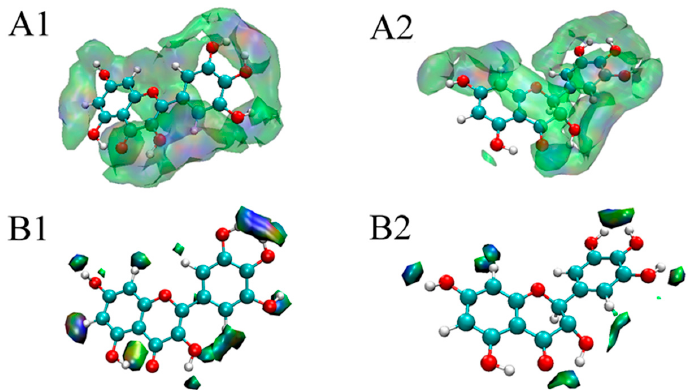
Figure 4. Visual weak interactions of myricetin and dihydromyricetin with α -glucosidase (( A1 , A2 ) are the color-filled δ ginter isosurfaces around myricetin and dihydromyricetin at an isovalue of 0.001, respectively; ( B1 , B2 ) are the color-filled δ ginter isosurfaces around myricetin and dihydromyricetin at the isovalue of 0.01, respectively).